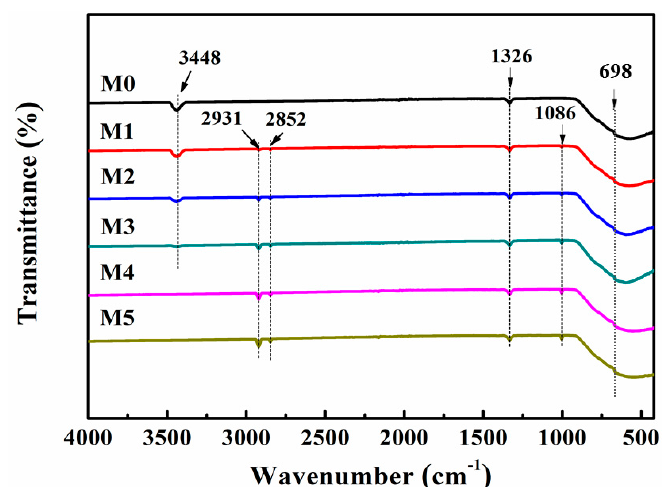
Figure 5. FTIR spectra of OS-modi fi ed AlN powder.